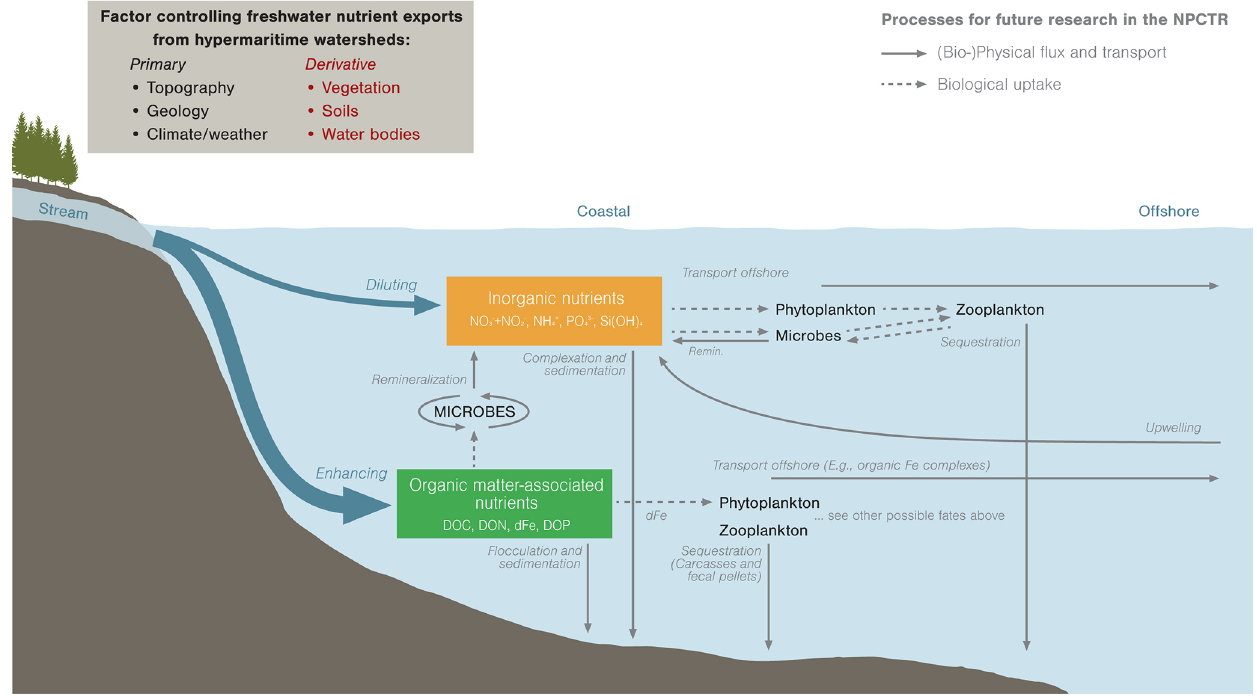
Figure 8. Conceptual framework highlighting nutrient dynamics in coastal waters downstream of watersheds dominated by bog forests of the NPCTR. The size of arrows shows the relative magnitude of these processes (if known). Grey arrows indicate fluxes that are poorly quantified in this